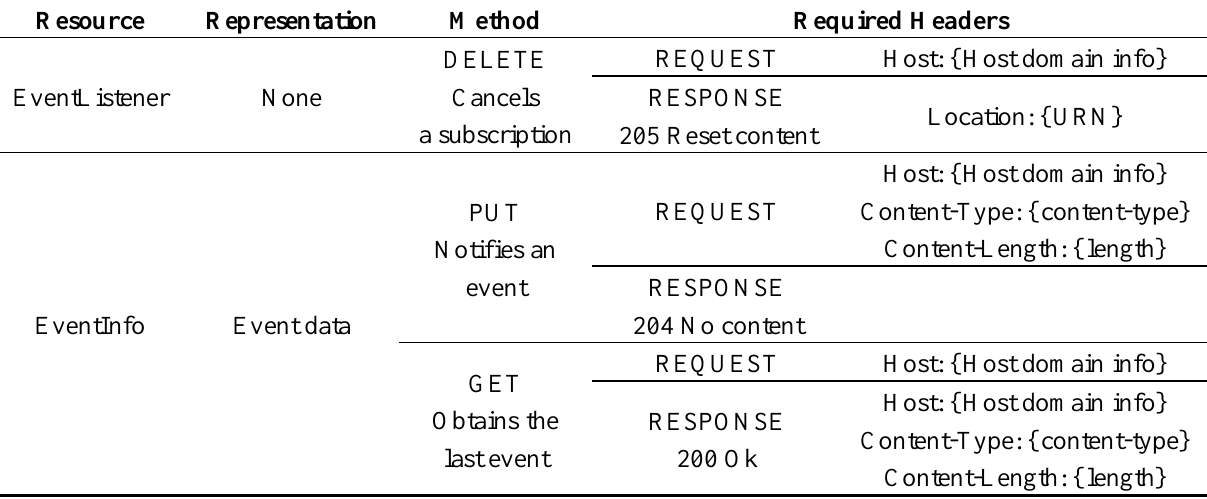
Table 3. Subscriber’s resource specification